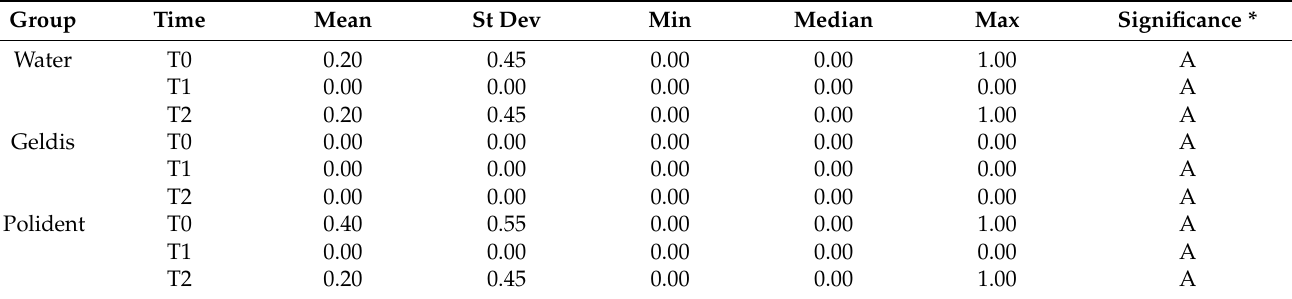
Table 7. Descriptive statistics of Red Complex loads